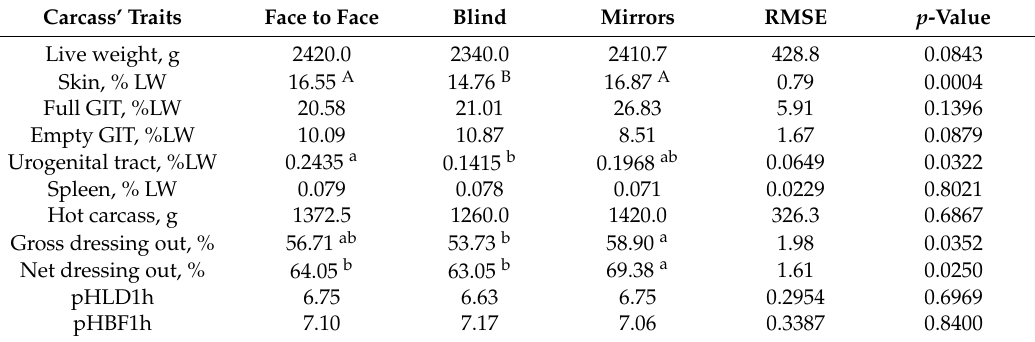
Table 3. E ff ect of housing systems on “hot” carcass traits (within 1 h from